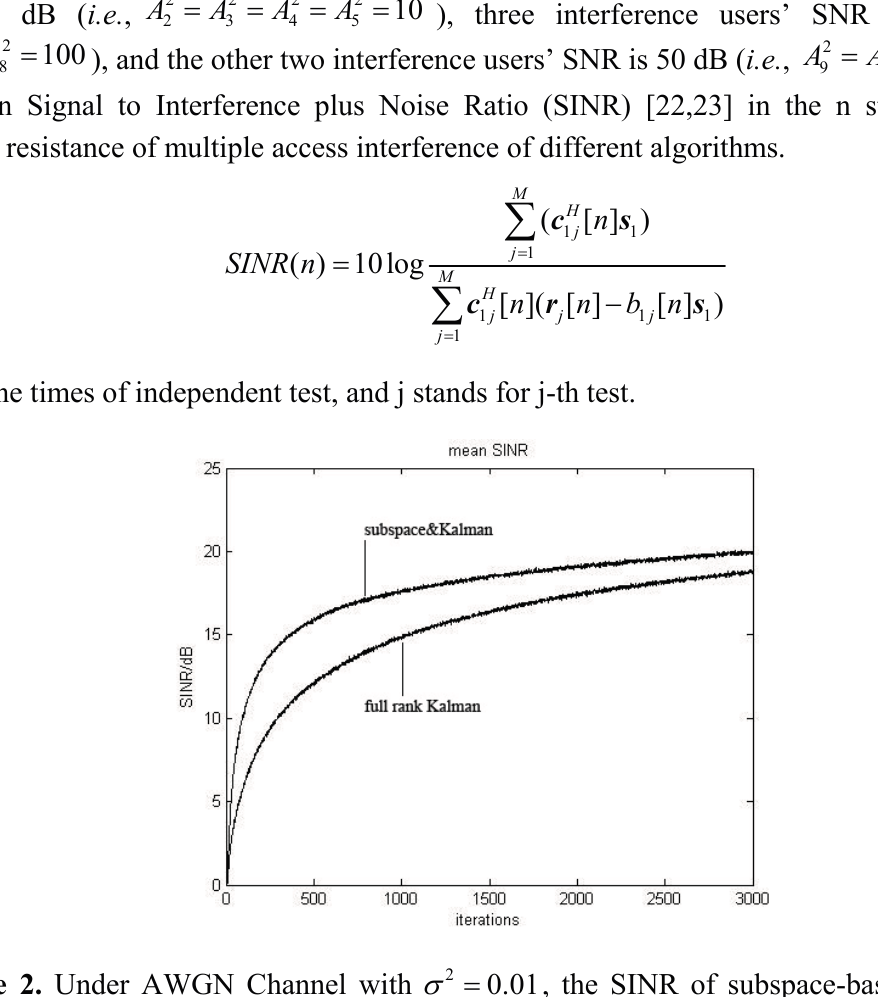
Figure 2. Under AWGN Channel with 2 0.01   , the SINR of subspace-based Kalman filter and full-rank Kalman filter against number of iterations.